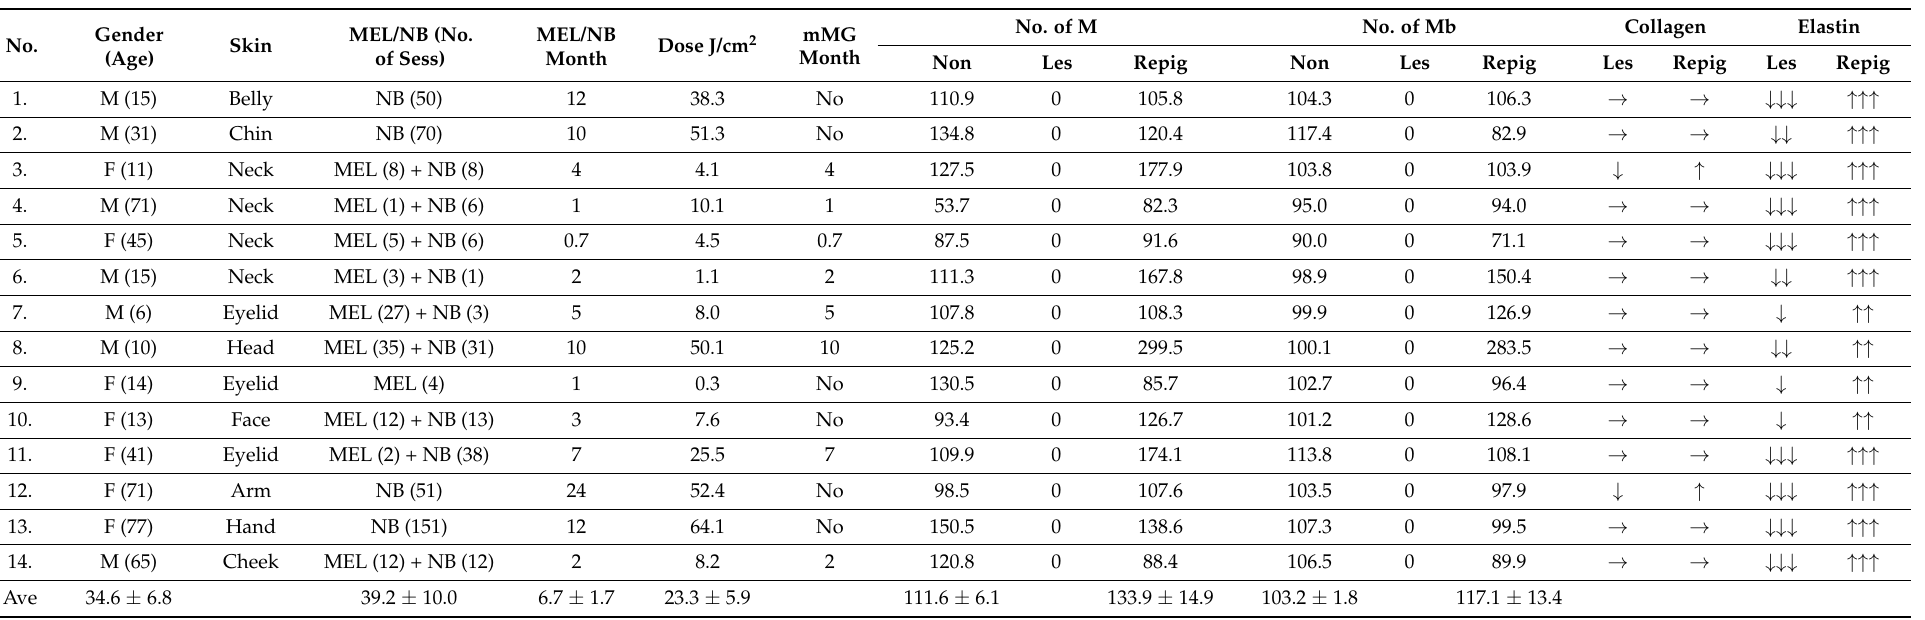
Table 1. Collagen and elastin fibers in nonlesional, vitiliginous, and repigmented skin after exposures with MEL/NB-UVB and/or mMG in addition to